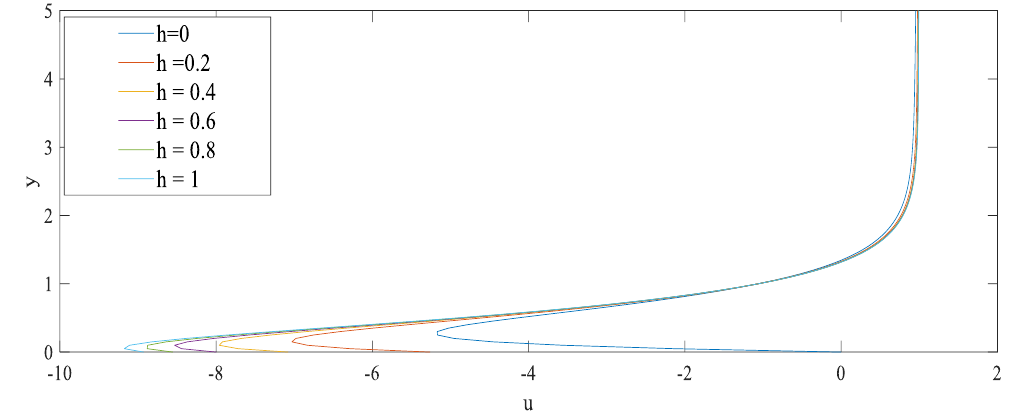
Figure 6. Velocity profile against displacement variable y for Nr=0.1, Pr=5, M=2, b=0.5, Sc=2, Kr=0.5, Du=0.5, Q=0.2, Q1=0.3, e=0.001, eta(η) =0.2, n=0.1, Kp=0.3, Gr=5, n 1 =0.2, Gm=0.3 at